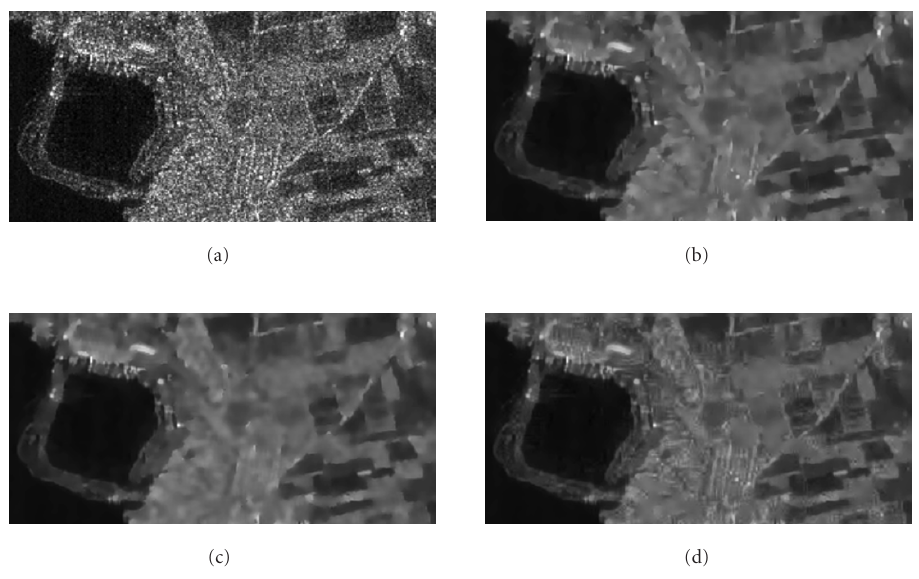
Figure 13: Real SAR image processing example: (a) the original L-band SAR image, (b) the output of MSF 7 × 7, (c) the output of two- component hard-switching LAF, and (d) the output of three-component hard-switching LAF. All filtering is performed implying prepro- cessing stage (see Section 6) for speckle